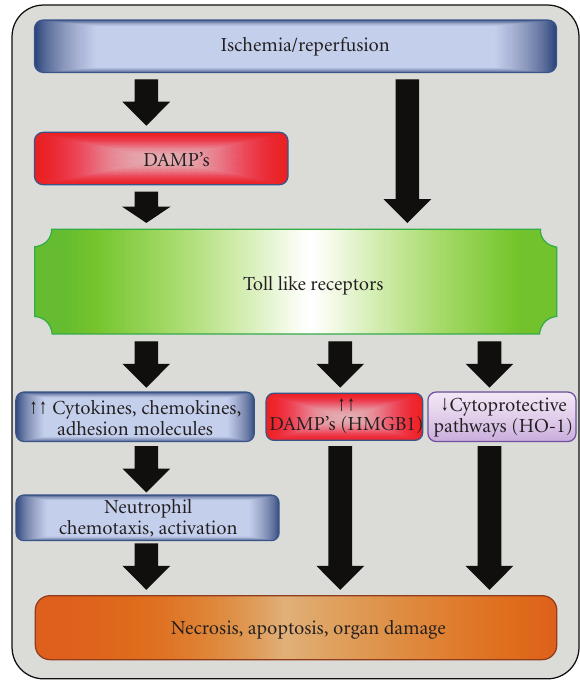
Figure 2: TLRs coordinate the response to hepatic I/R injury. Toll- like receptors are proximal to most elements of hepatic I/R injury. Following an ischemic insult, TLR activation by circulating DAMPs sets o ff signaling cascades in multiple cell types that coordinates the inflammatory response. Both TLR4 and TLR9 activation on hepatic nonparenchymal cells promotes production of proinflammatory cytokines, leading to additional neutrophil recruitment and organ damage. TLR4 activation has also been shown to augment the release of circulating DAMPs and may suppress protective cellular